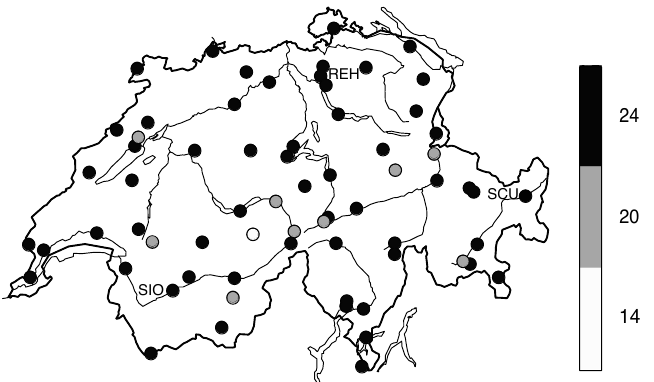
Figure 1. Location of the 68 stations covered by this work and number of calculated indices at each station. Per station a set of at least 14 indices is available, the maximum number is 24. Three stations, representing the agricultural climate of Switzerland are tagged: Sion (SIO) in the dry Rhone valley in Valais, Zurich / Reckenholz (REH) in the Alpine forelands and Scuol (SCU) in the Alpine region of the